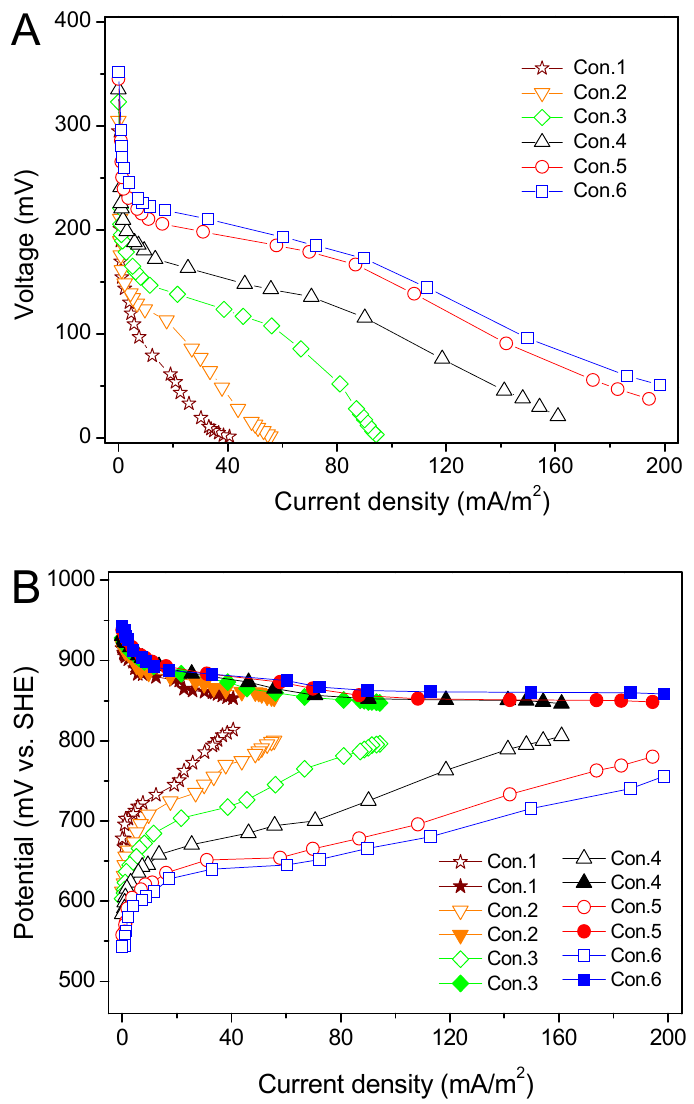
Figure 6. Polarization curves of ( A ) whole MFCs and ( B ) electrodes (cathode: filled symbols; anode: open symbols) under different influent concentrations (Con.1 to Con.6 represent NH 4+ ‐ N concentrations from 25 mg/L to 250 mg/L).